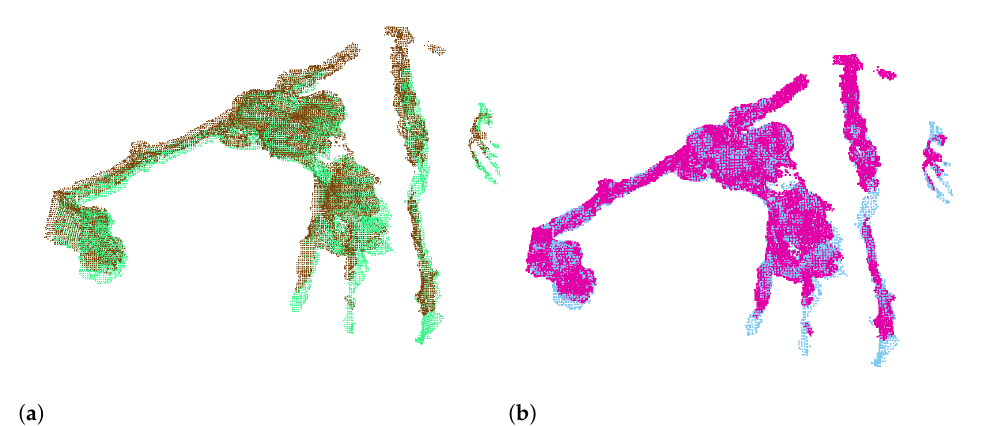
Figure 6. Images of the two point clouds before applying ICP and after applying ICP. ( a ) Before ICP. ( b ) After